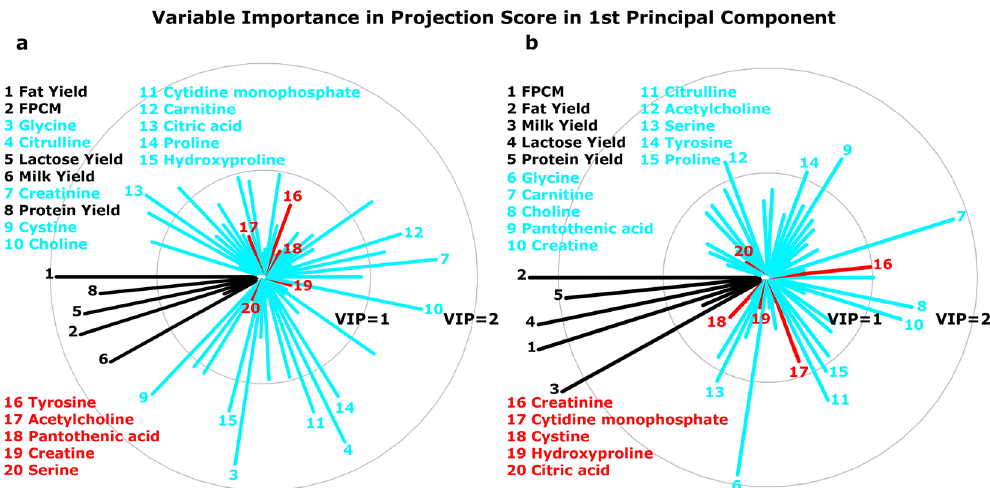
Figure 2. Variable importance in projection (VIP) scores in the first principal component calculated by partial least squares (PLS) to estimate the energy balance of dairy cows in lactation week 2 ( a ) and week 7 ( b ). The top 15 metabolites with relatively higher VIP score are shown. The relative higher VIP score means that variable has higher capability to predict energy balance in PLS analysis. Black line and text represent milk production traits, blue line and text represent milk metabolites with relatively higher VIP score, and red line and text represent milk metabolites which were in the top 15 in one week, but not in the other week. Abbreviation: FPCM, fat- and protein-corrected milk.